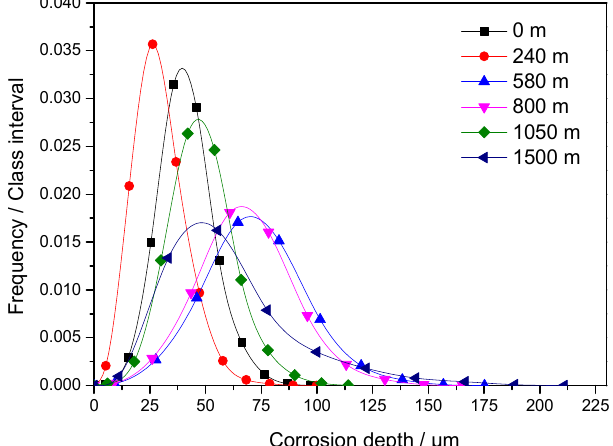
Figure 11. Frequency density distribution map of the corrosion depths of samples corroded at different well depths.